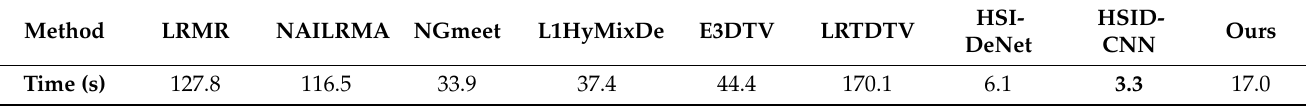
Table 5. Classification accuracy results for Indian